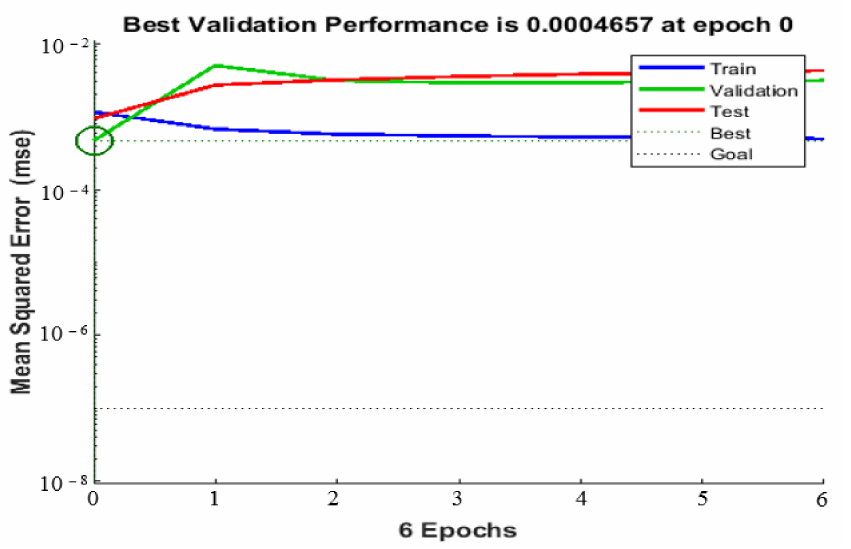
Figure 15. ANN best validation. From Figure 16, it can be observed that the fit lines (colored lines in blue, green, red, and black) are identical to the dashed lines for all subplots. This means that the